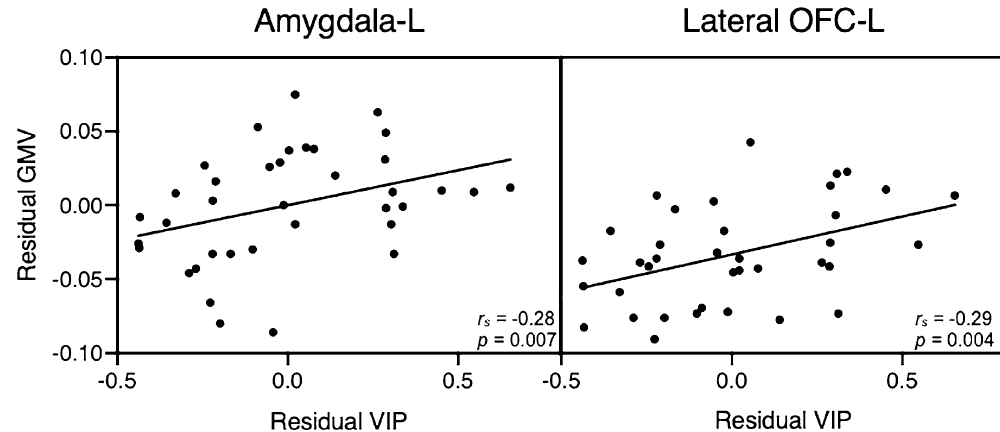
Figure 5. Partial correlation between VIP and grey matter. The graphs show the partial regression plot of the adjusted left amygdala grey matter volume and residual VIP (left) and the adjusted left lateral orbitofrontal cortex grey matter volume and residual VIP (right) influenced by the covariates age, total intracranial volume, HADS anxiety and